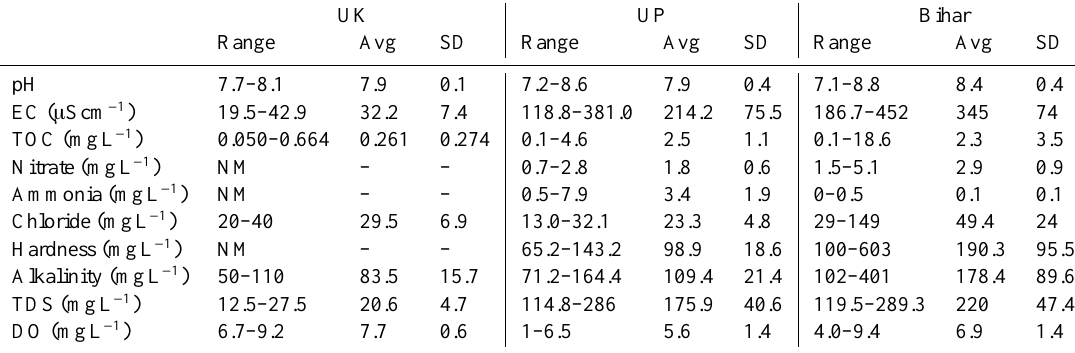
Table 4. River Water Quality of Ganga Basin covered during sampling campaigns (December 2010–August 2011).